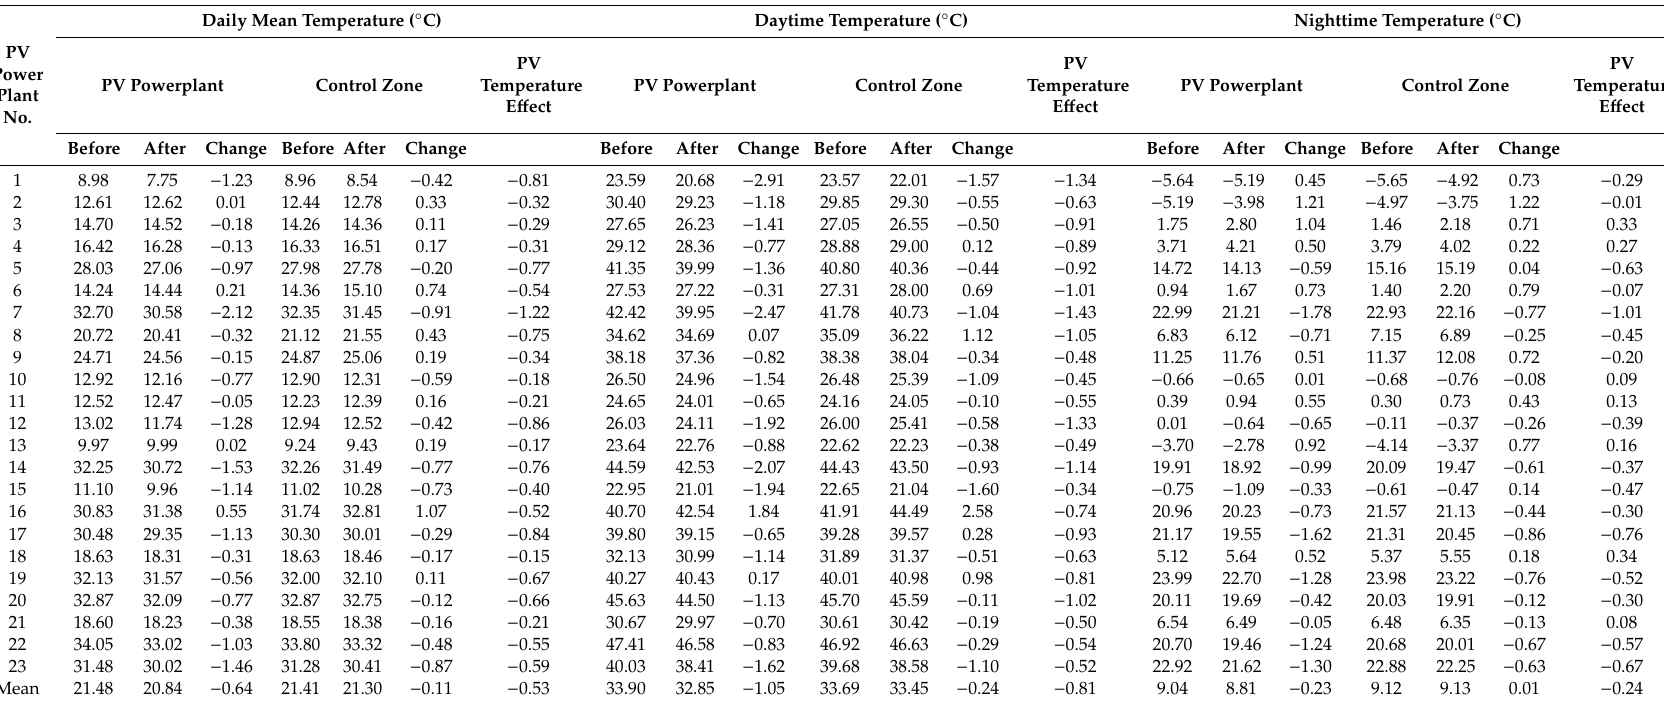
Table 3. Summary of surface temperature in PV powerplants and control zones before and after the installation of PV powerplants and the PV temperature e ff ects of each PV